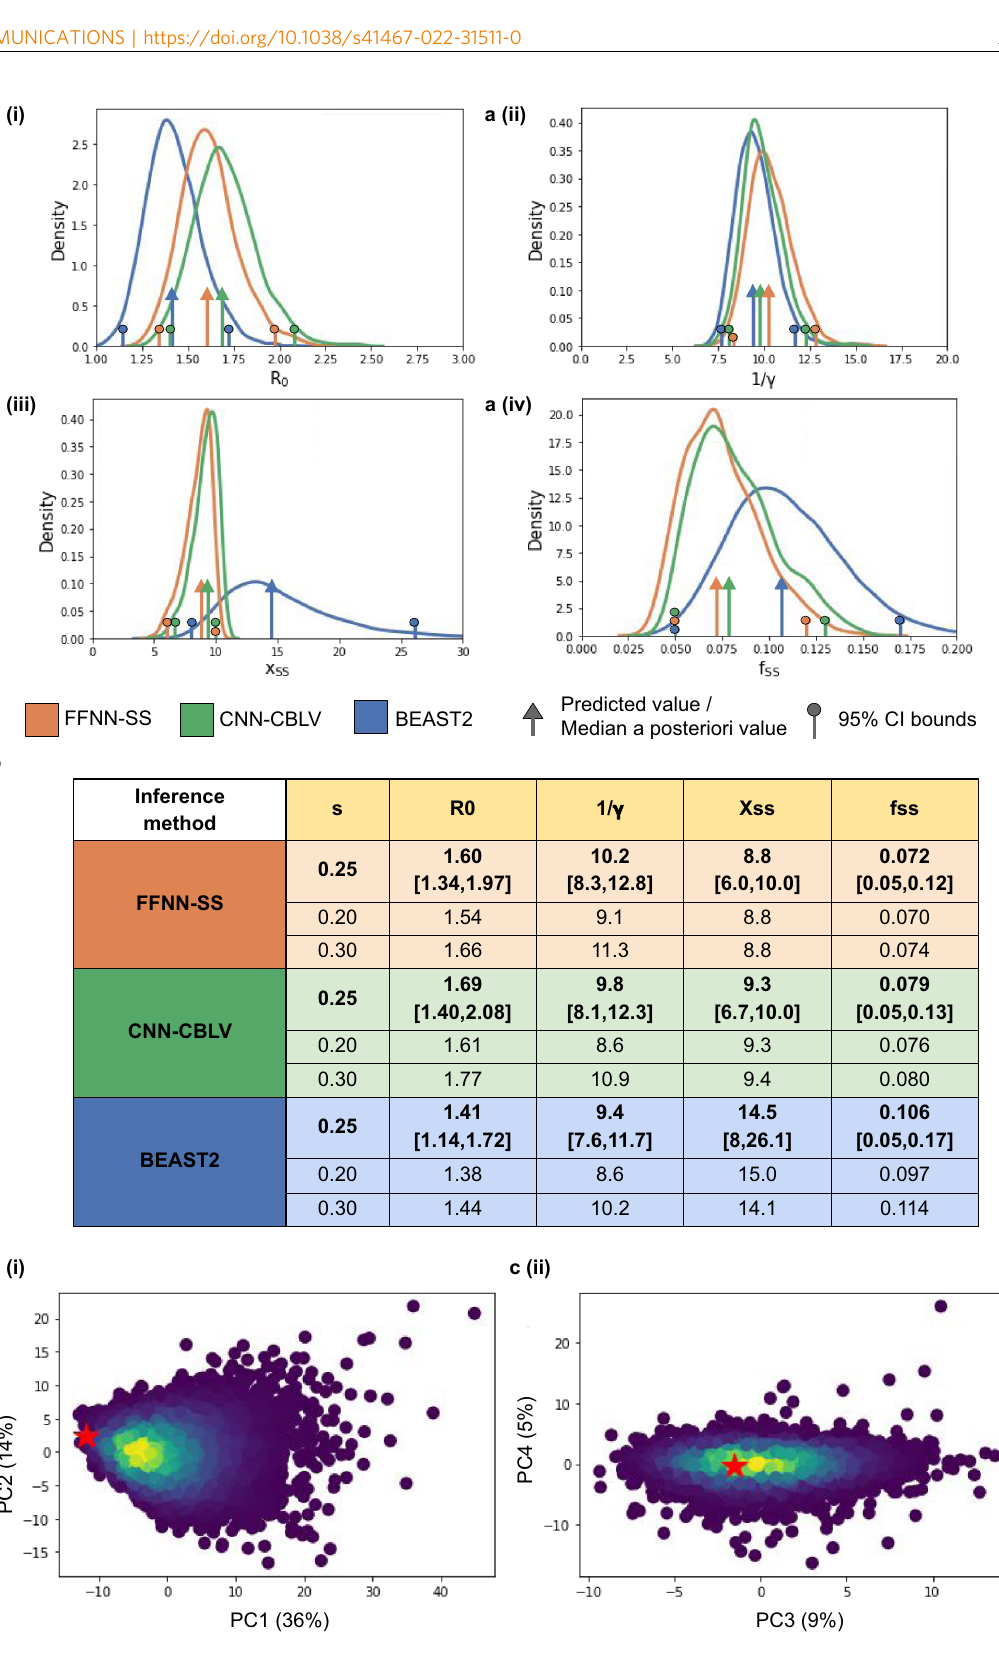
x and y coordinates of this plot; Supplementary Fig. 8), consistent with the fact that the probabilistic, sampling component of the BDSS model is an oversimpli fi cation of actual sampling schemes, which depend on contact tracing, sampling campaigns and policies,